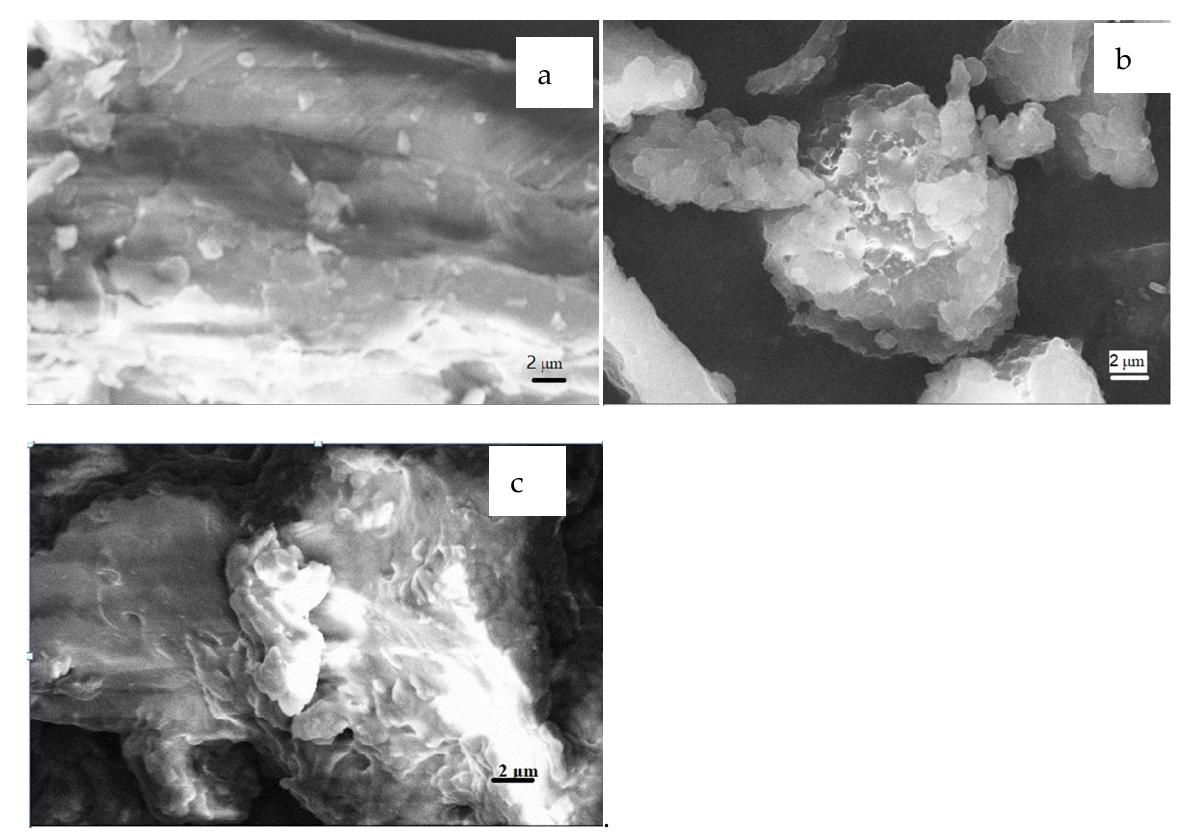
Figure 3. XRD patterns of original loofah, loofah-g-GMA and MML. ( Note: The arrows point to the position of the diffraction peak )